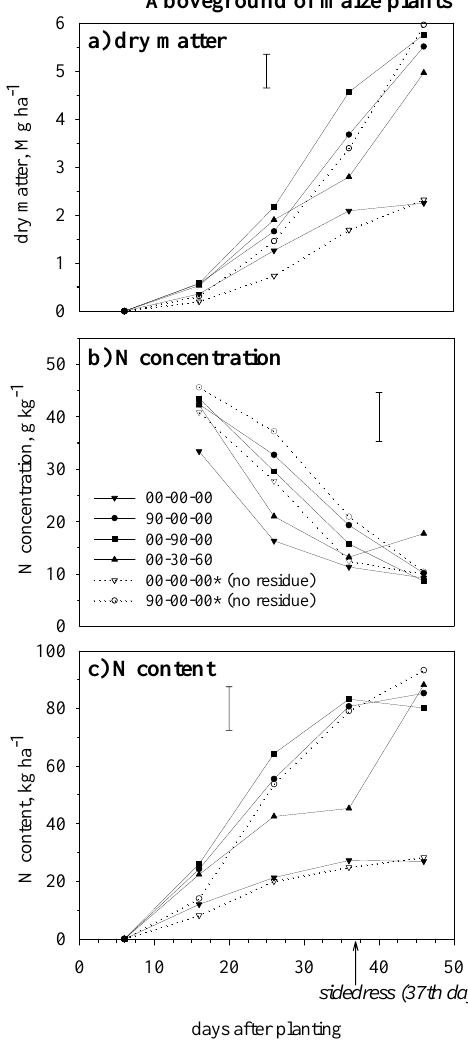
Figure 4. Amount of dry matter (a), N concentration (b) and N content (c) in aerial part of maize plants, as affected by the timing of N